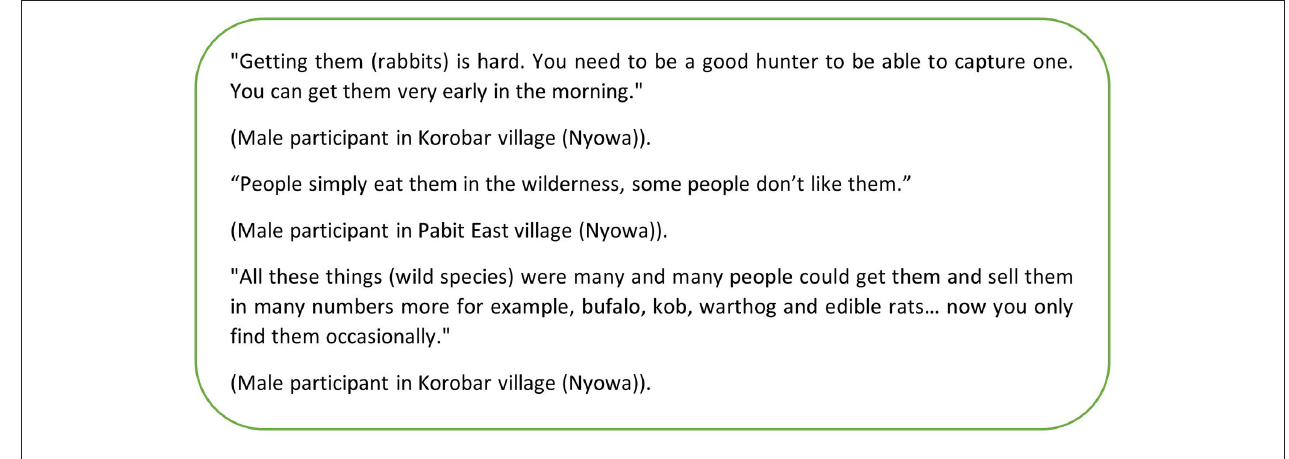
FIGURE 11 | Quotes from male focus group discussion participants about sales in Acholi